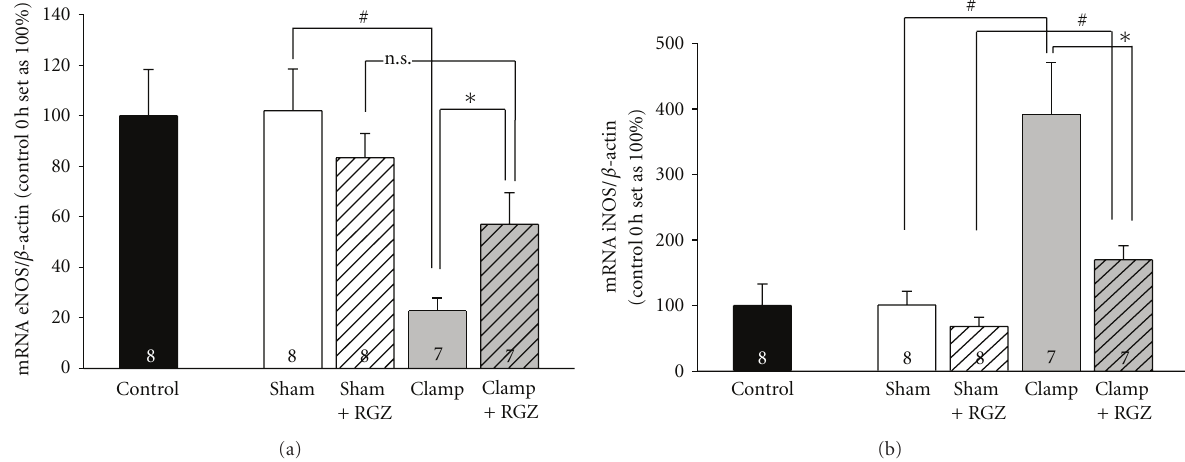
Figure 3: E ff ect of 5mg/kg rosiglitazone (RGZ) on the mRNA levels of (a) endothelial and (b) inducible NO-Synthase (eNOS and iNOS) in Sprague-Dawley rats in renal I/R injury. Total RNA was generated from kidney cortex. Real-time PCR against eNOS, iNOS, and β -actin was performed as described in Section 2. Quantification was performed using the DDC T method using β -actin as a reference gene, and expression in untreated control animal (control 0h) was normalized to 100. n is given in the respective bars. (a) E ff ect RGZ on the mRNA levels of eNOS. The amount of eNOS mRNA signal normalized to the respective signal from β -actin. # , ∗ Statistically significant di ff erence as indicated. n.s.: Statistically not significant. (b) E ff ect of RGZ on the mRNA levels of iNOS. The amount of iNOS mRNA signal normalized to the respective signal from β -actin. # , ∗ Statistically significant.